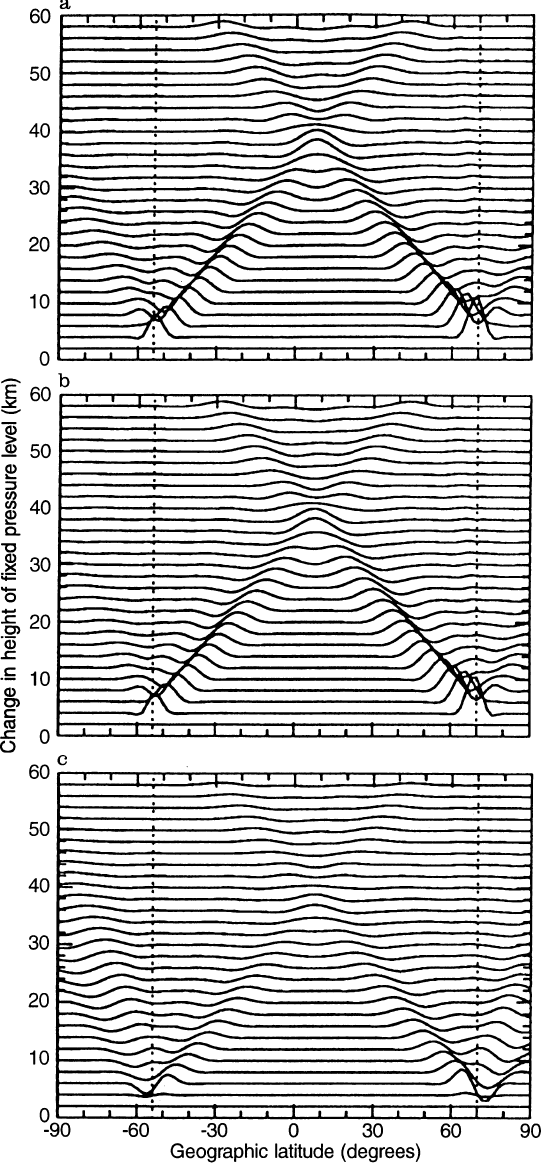
Fig. 5a–c. As for Fig. 4, except that the enhanced electric field is zonal. The plotting convention is identical to that of